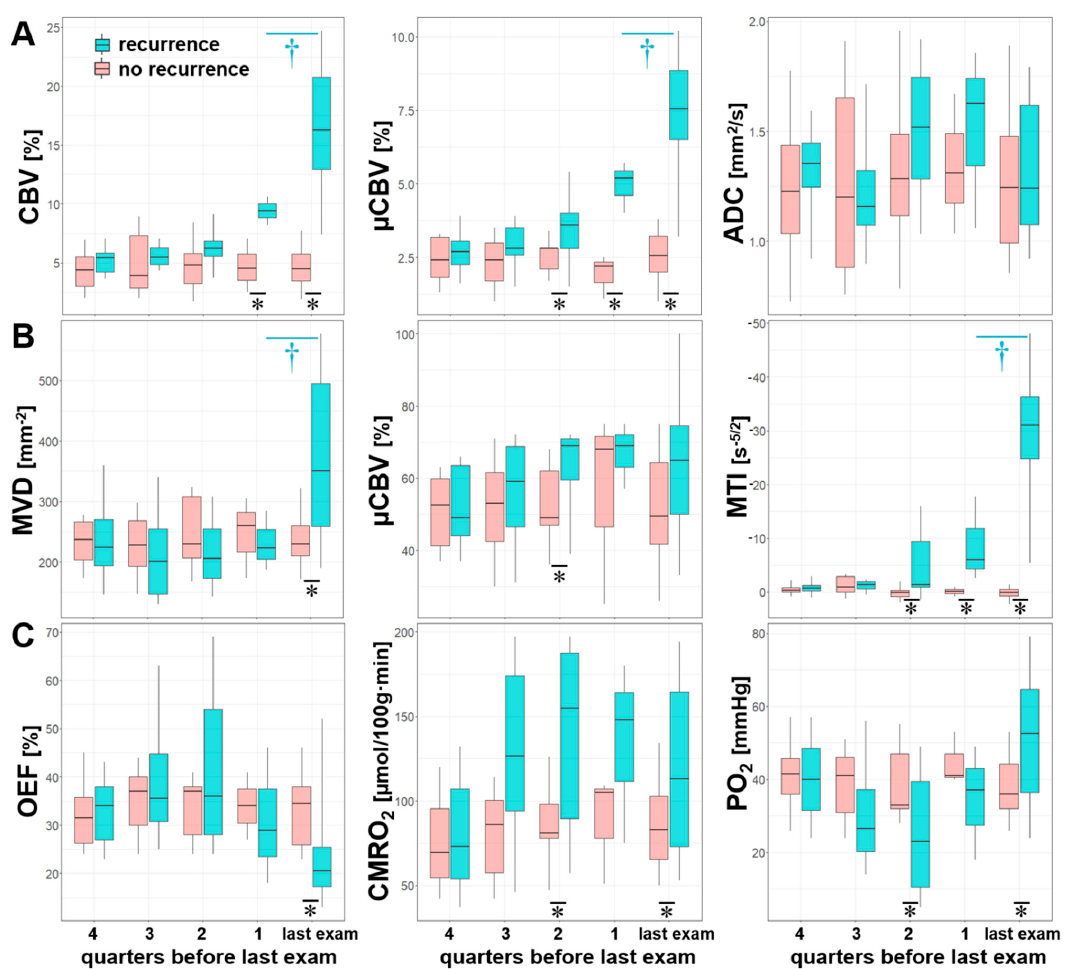
Figure 6. Series of box and whisker plots of quarterly pooled MRI biomarker of ( A ) perfusion (CBV and µCBV) and microstructural density (ADC), ( B ) microvascular architecture (MVD and VSI) and neovascularization activity (MTI), and ( C ) oxygen metabolism (OEF, CMRO 2 , and PO 2 ) for AG recurrence (cyan) and stable disease (no recurrence, red), respectively. Crosses (†) mark significant differences between two successive quarters within the same patient subgroup, and asterisks (*) mark significant differences between patient subgroups within the same quarter ( p < 0.05).